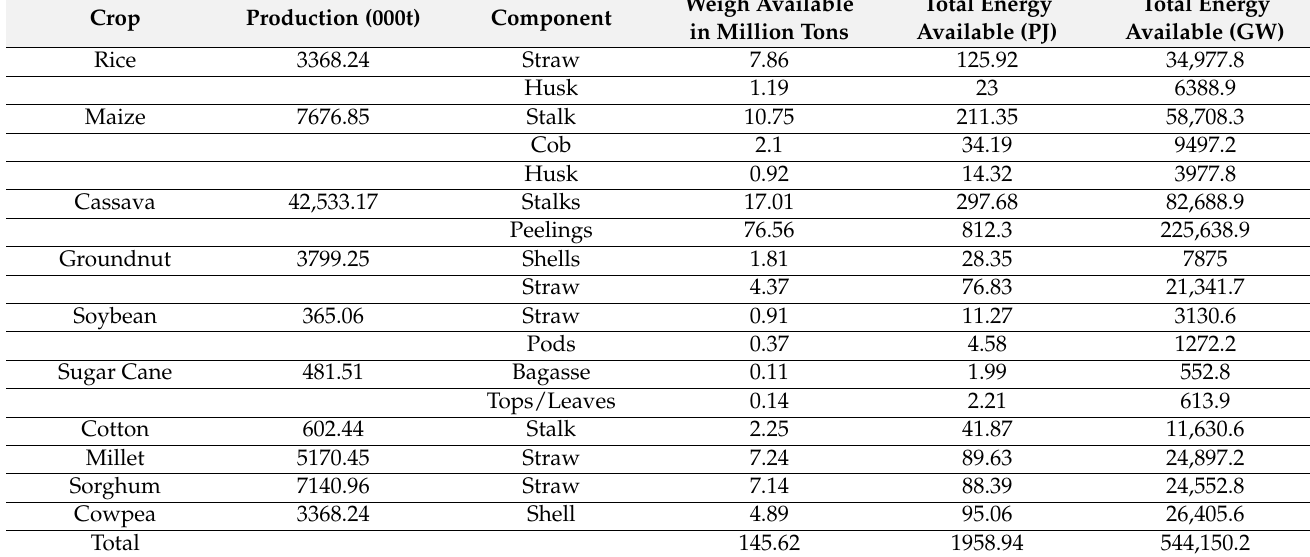
Table 6. Residue estimates from agricultural crops in Nigeria (2010). Data taken from [48].